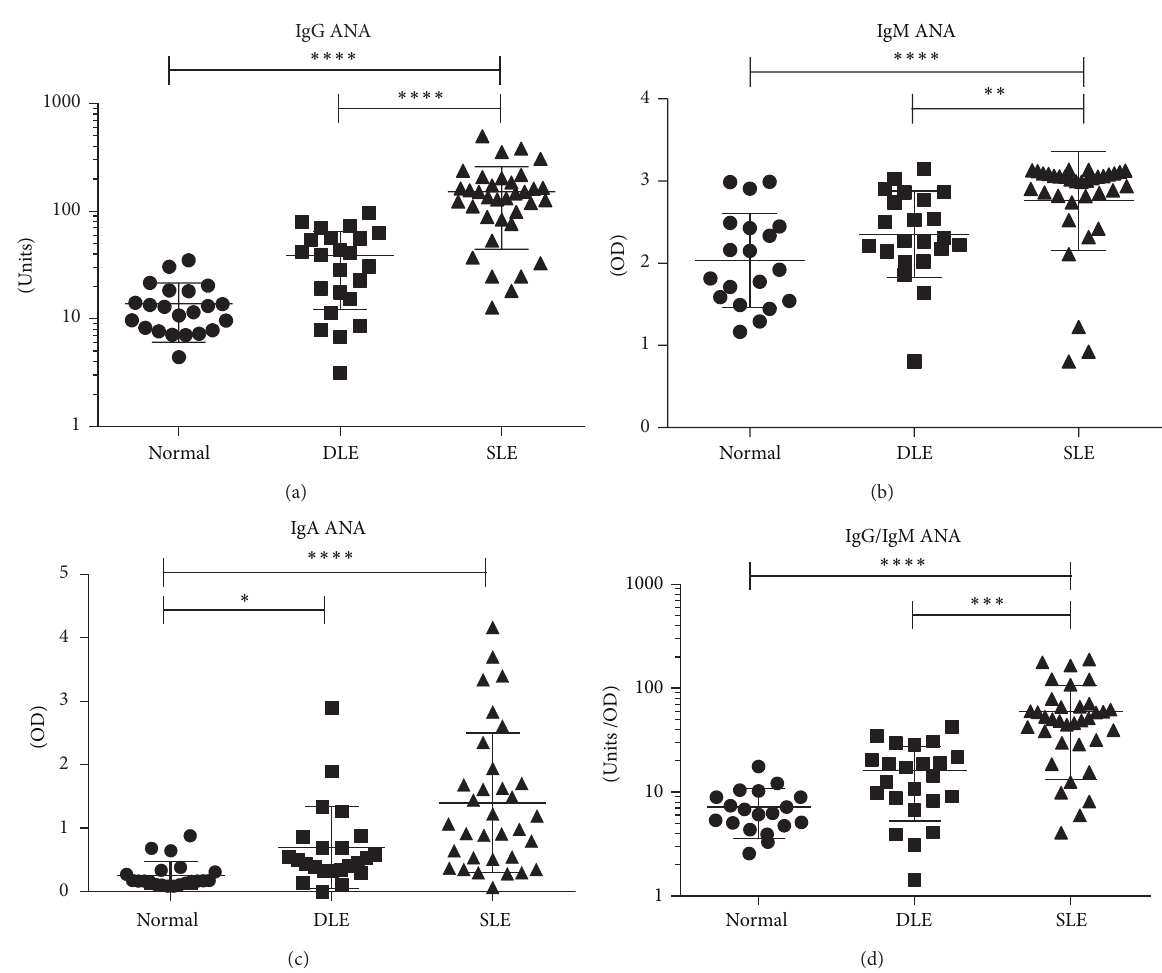
Figure 1: ELISAs showed significant differences in ANAs in DLE and SLE patients. ((a)–(d)) Levels of ANAs for IgG (a), IgM (b), and IgA (c), as well as the ratio of IgG/IgM ANAs (d), were measured in the sera of normal, DLE, and SLE patients. There are missing IgM ANA data for three normal samples and missing IgA ANA data for one normal sample due to insufficient quantities of sera. Kruskal-Wallis test and Dunn’s post hoc test for multiple comparisons were performed for all analyses. ∗ 𝑃 ≤ 0.05 , ∗∗ 𝑃 ≤ 0.01 , ∗∗∗ 𝑃 ≤ 0.001 , and ∗∗∗∗ 𝑃 ≤ 0.0001